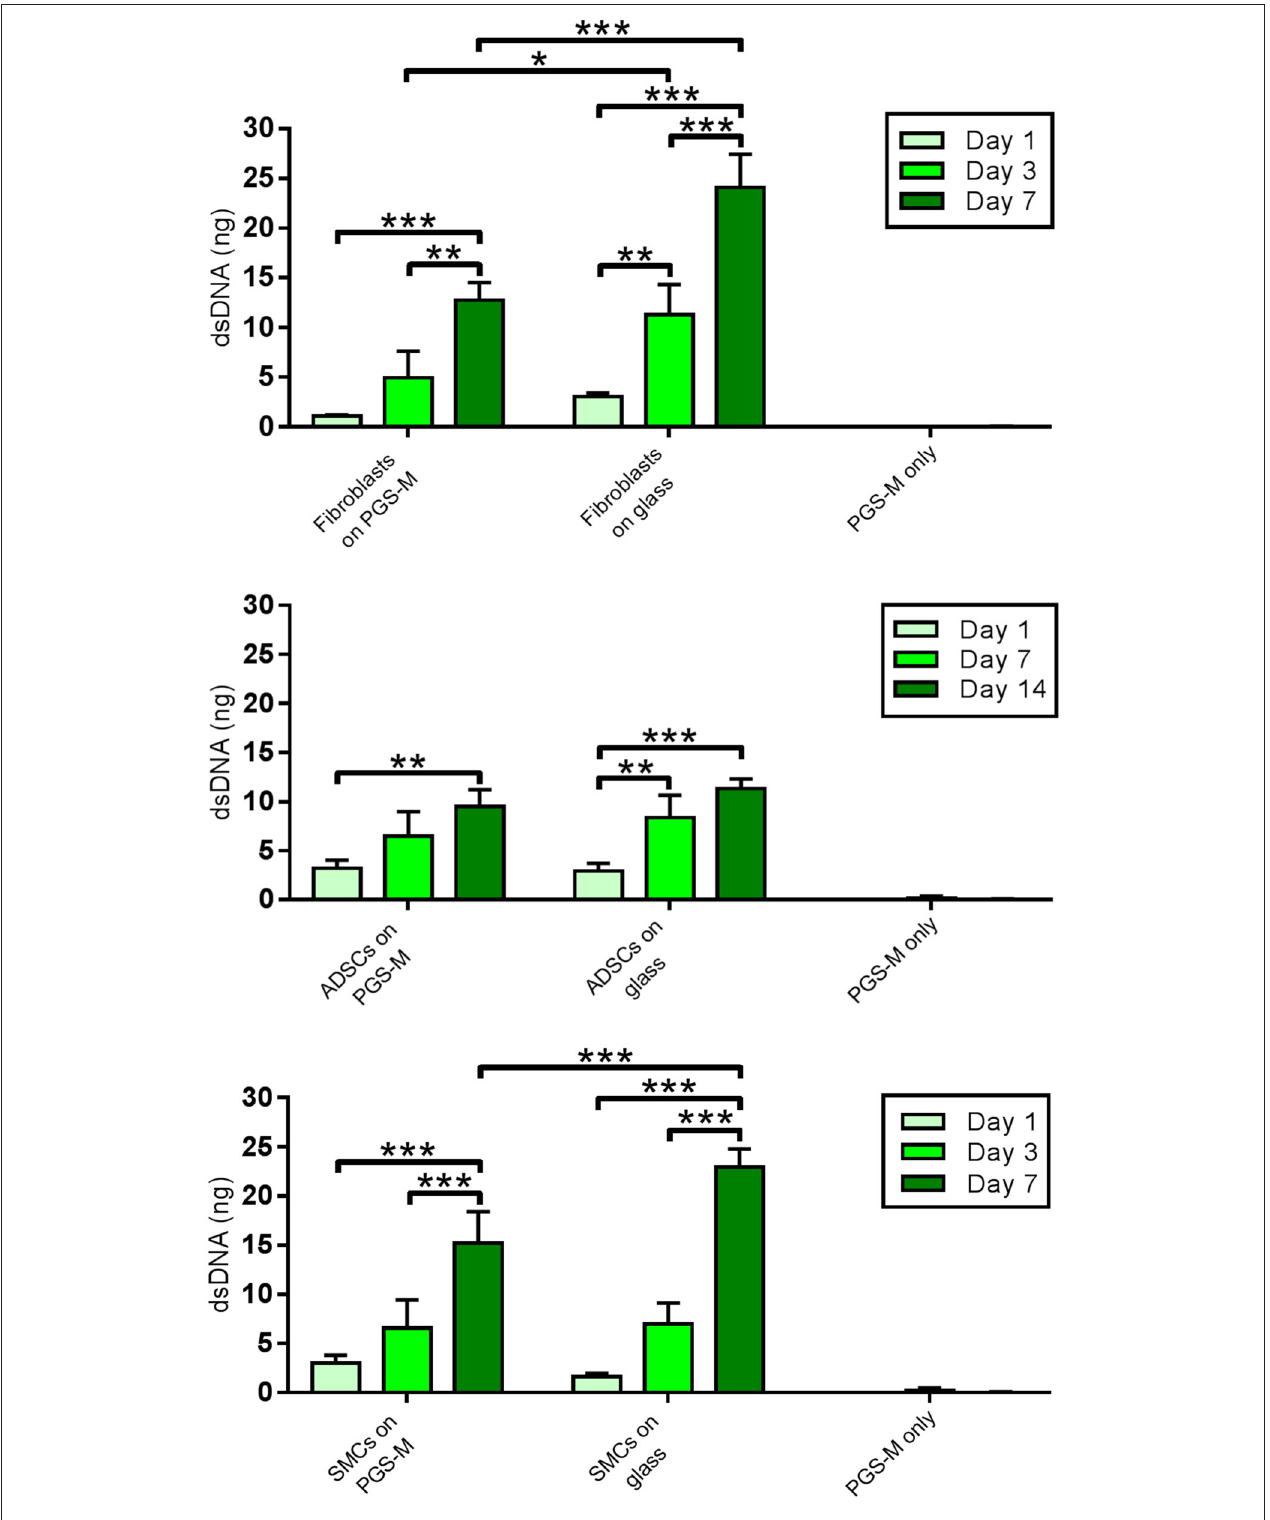
FIGURE 11 | PicoGreen ® assay for dsDNA content of Fibroblast, ADSC, and SMC cultures on 30% Low M w PGS-M surfaces. Positive controls were cells cultured on borosilicate glass. Negative controls were unseeded PGS-M surfaces (PGS-M only) ( n = 3). The degree of significance is indicated as *** P ≤ 0.001, ** P ≤ 0.01 and * P ≤